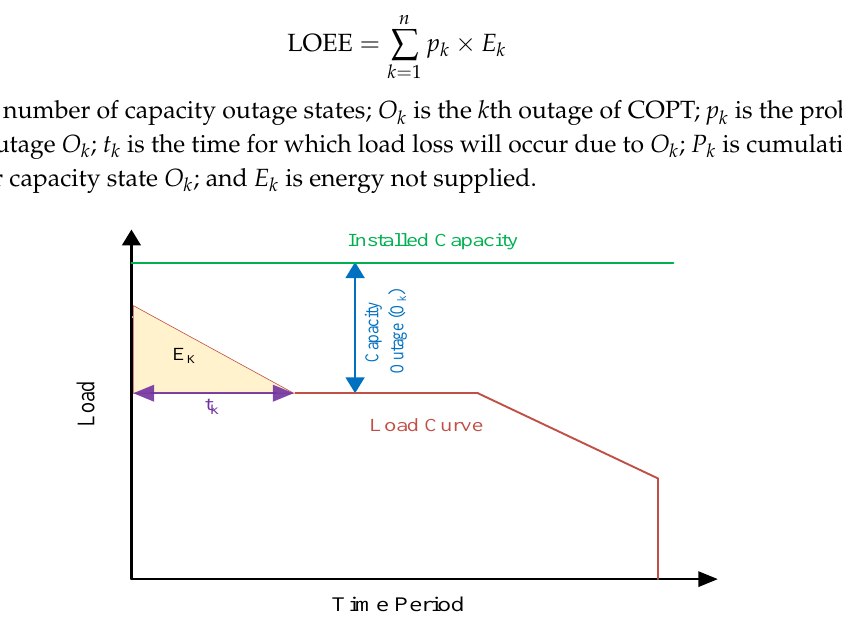
Figure 2. Evaluation of loss of load expectation (LOLE) and loss of energy expectation (LOEE) using an hourly load curve.